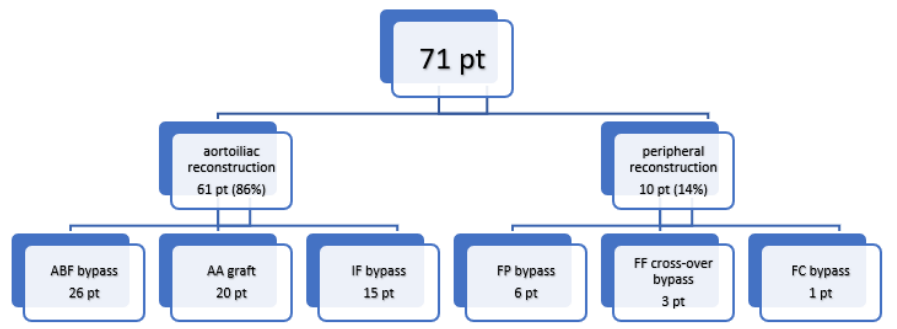
Figure 1. Types of reconstructions included in the study.